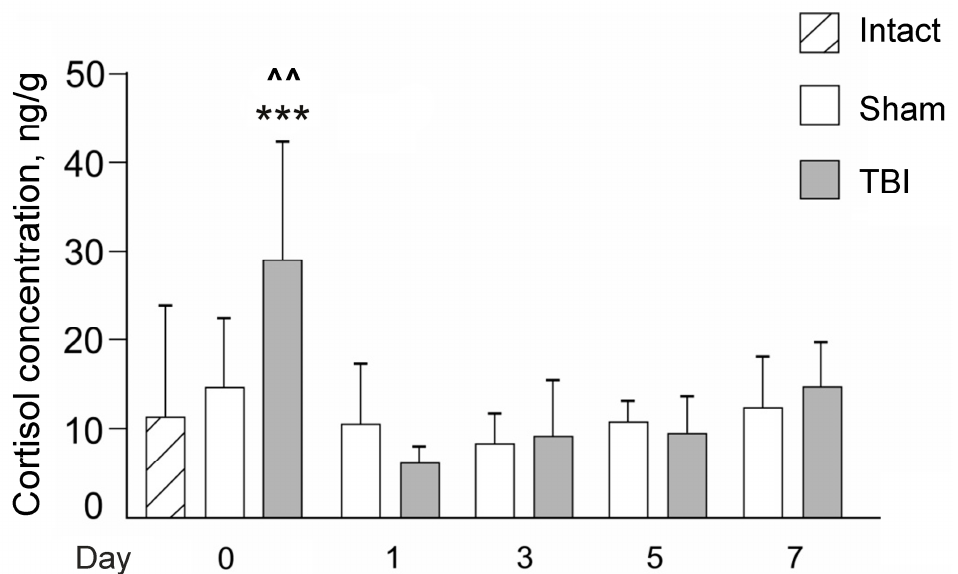
Figure 4. Effects of the laser-induced lesion (TBI model) on zebrafish whole-body cortisol on Day 0 (30 min after the lesion), 1, 3, 5, and 7 days after the injury. White bars represent Sham groups, grey bars—TBI groups; hatched bar—intact zebrafish. Data are expressed as mean ± SEM. *** p < 0.001 vs. Sham group on Day 0; ^^ p < 0.01 vs. Intact zebrafish on Day 0.